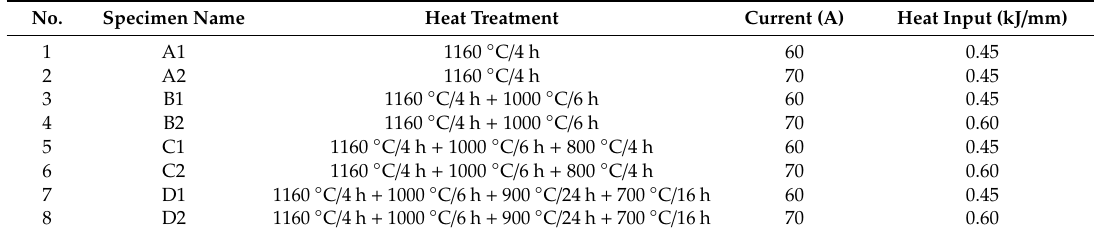
Table 2. List of heat treatments applied to the specimens.